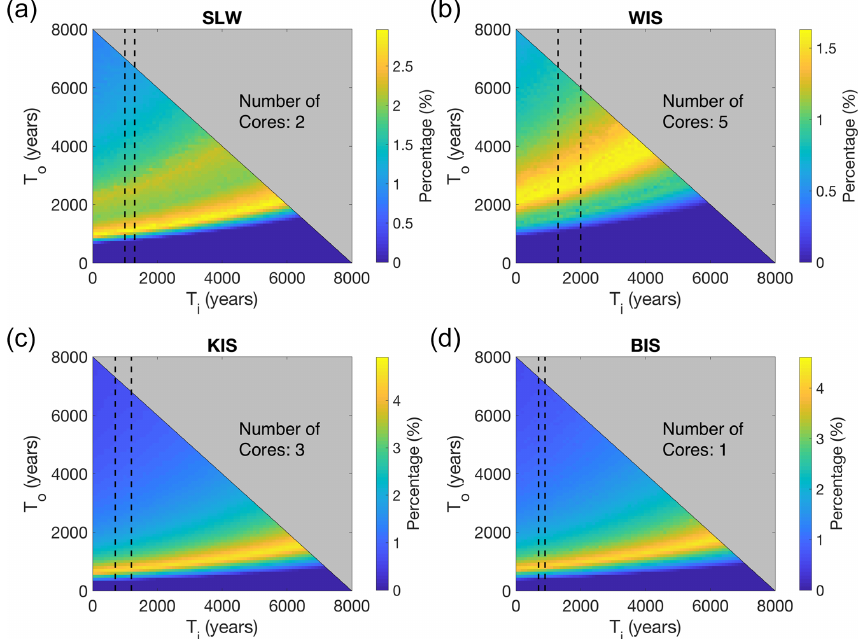
Figure 7. Results of radiocarbon modeling for all 11 subglacial cores. The axes correspond to the length of time the grounding line position had either retreated behind the sites ( T o ) or advanced over them ( T i ). The color bar indicates the percentage of model runs which produced Fm and TOC that fell within the observed ranges for each core. A total of 103495644 model runs were performed for each core. Results from cores at the same field site are stacked on top of each other. Thus, the total number of model runs for each site is 206991288 for SLW, 517478220 for WIS, 310486932 for KIS, and 103495644 for BIS. The large number of model runs (which serve as the denominator in calculations of percentage of model matches) are responsible for the relatively small percentages shown in (a) – (d) . (a) SLW, (b) WIS, (c) KIS, and (d) BIS. Panels (a) – (d) indicate that the model provides better constraint to T o than T i . For example, (c) shows that at KIS, the model prefers ocean exposure durations ( T o ) of 600–1800 years but does not constrain the duration of grounding line readvance ( T i ). The dashed lines indicate the 32nd and 68th percentiles from the results of the duration of T i as determined by ionic and temperature diffusion